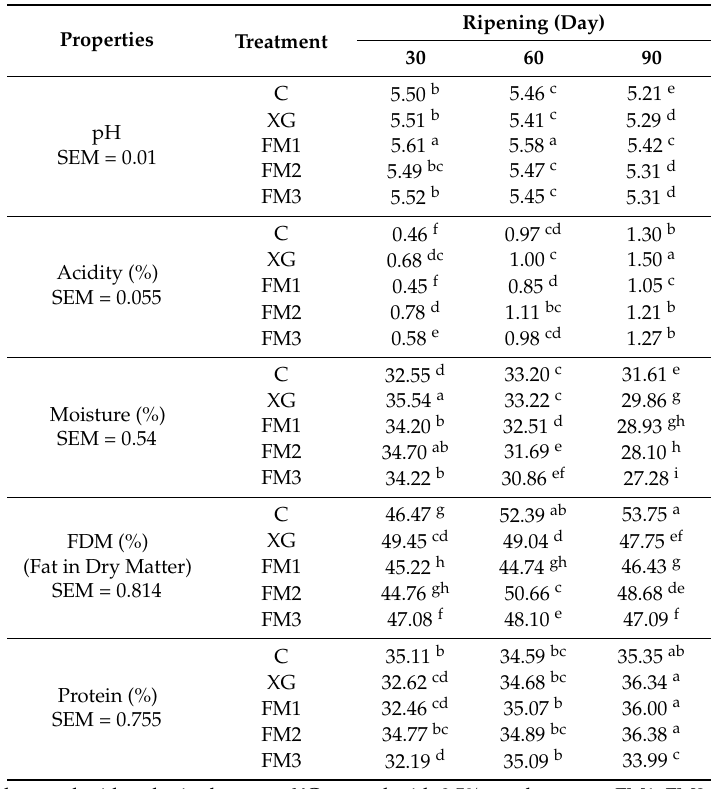
Table 1. Chemical composition of the cheeses throughout 90 days of